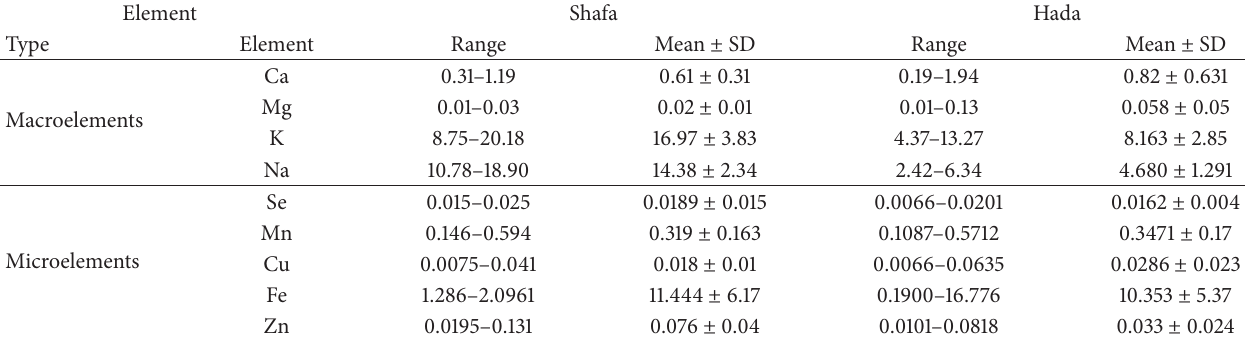
Table 2: Mean levels of macro- and microelements in Shafa and Hada soil samples (g/kg).